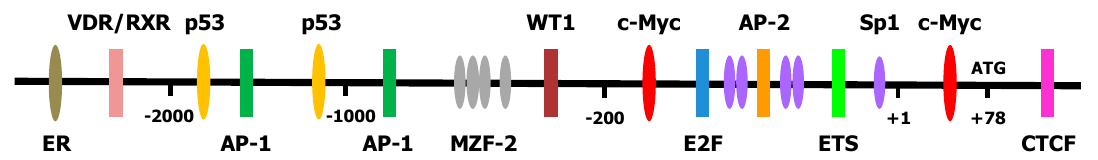
Figure 1. Promoter region of hTERT and transcription factors essential for regulating its activity. +1 is the transcription start site; +78 (ATG) is the first codon of the hTERT